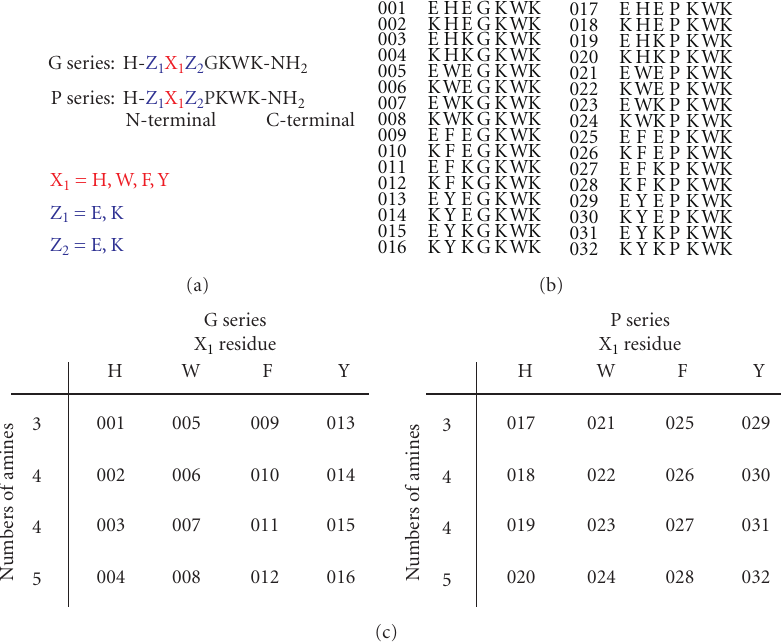
Figure 1: (a) Design of the G and P series peptide libraries. (b) Peptide identification number and sequence of each library peptide. (c) Distribution of peptides into the G or P